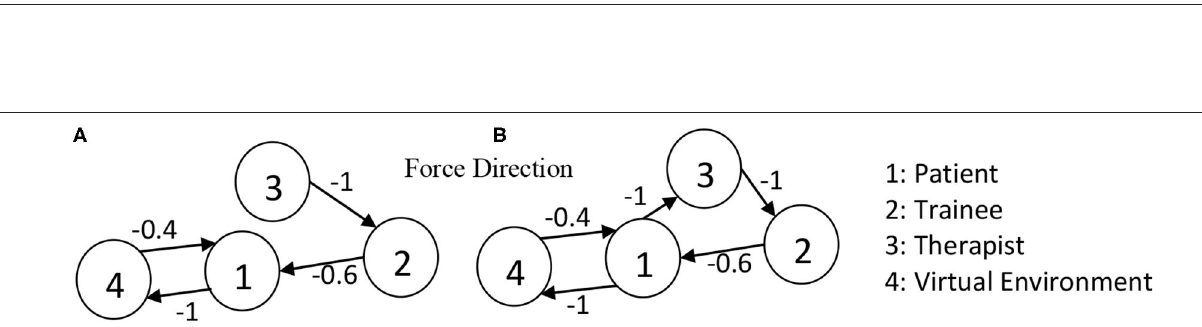
Frontiers in Robotics and AI | www.frontiersin.org